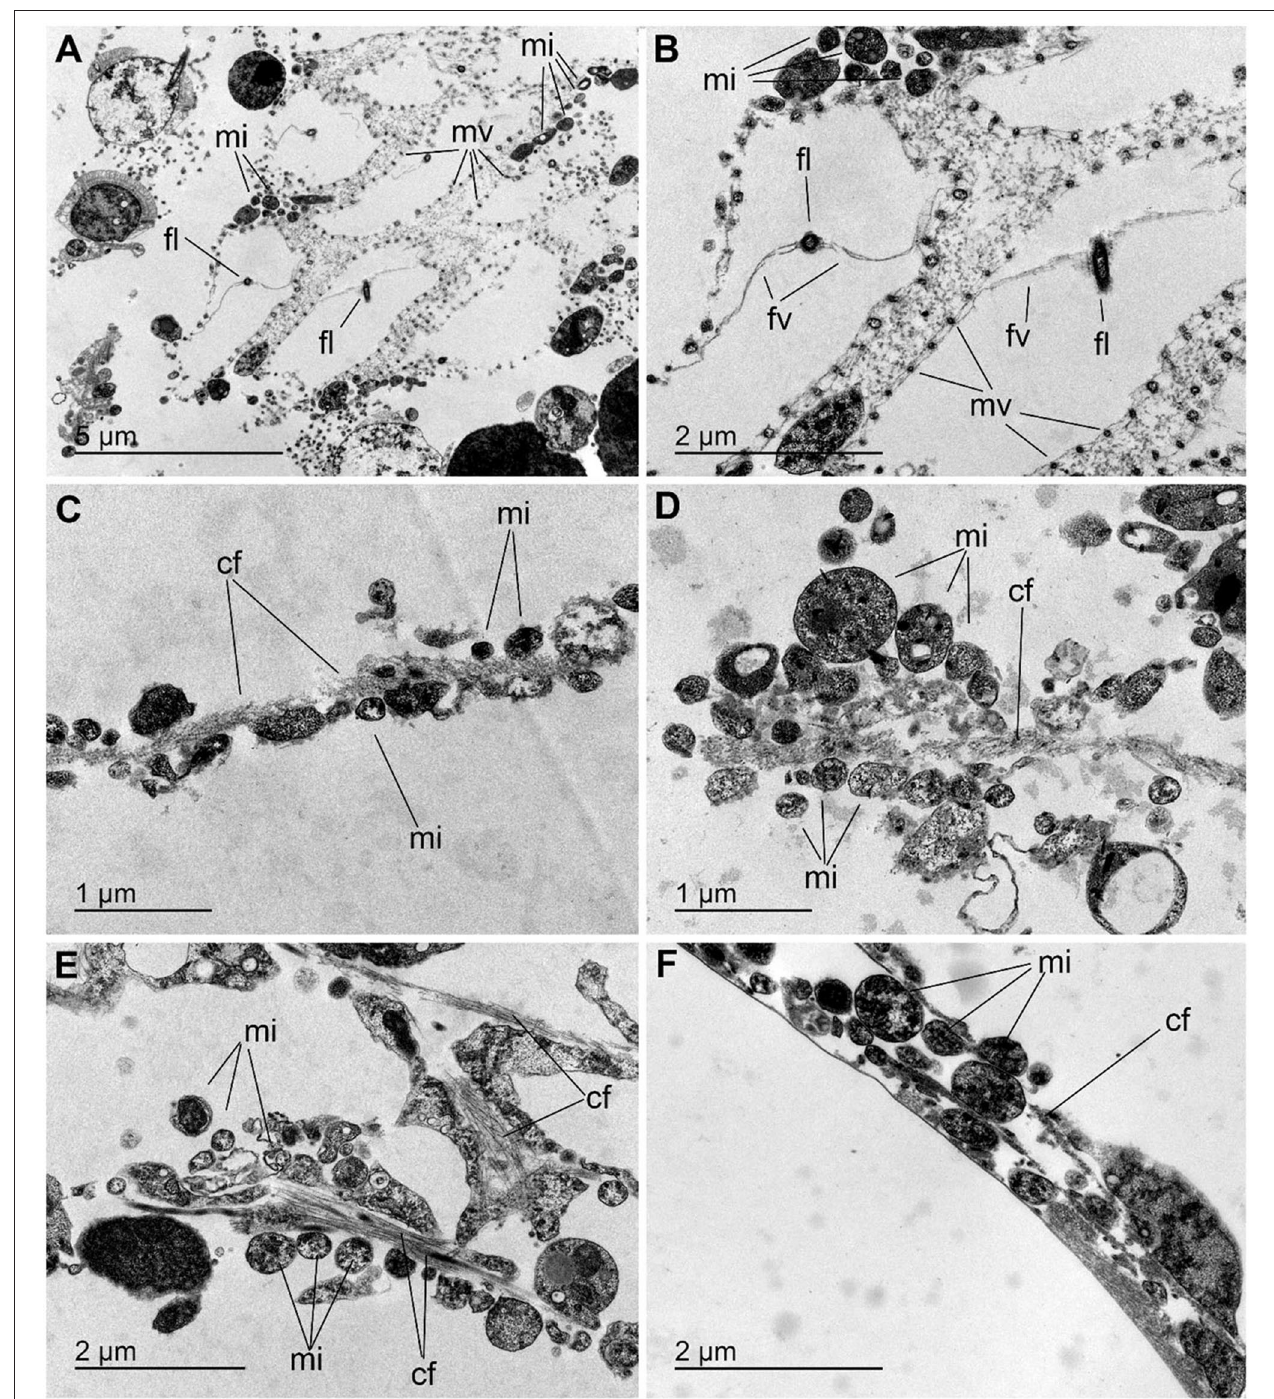
FIGURE 7 | Microbes in Schaudinnia rosea. (A,B) View of flagellated chambers showing the collar bodies with their microvilli (mv) and a flagellum (fl) provided with flagellar vanes (fv). Small groups of prokaryotic microorganisms (mi) occur intracellularly associated to the thin cytoplasmic zones sandwiched between the microvilli of adjacent collar bodies. (C–F) Views of small groups of microbes (mi) that gather around the packs of collagen fibrils (cf) that run across the thin mesohyl bands located within the trabecular strands of the sponge body.